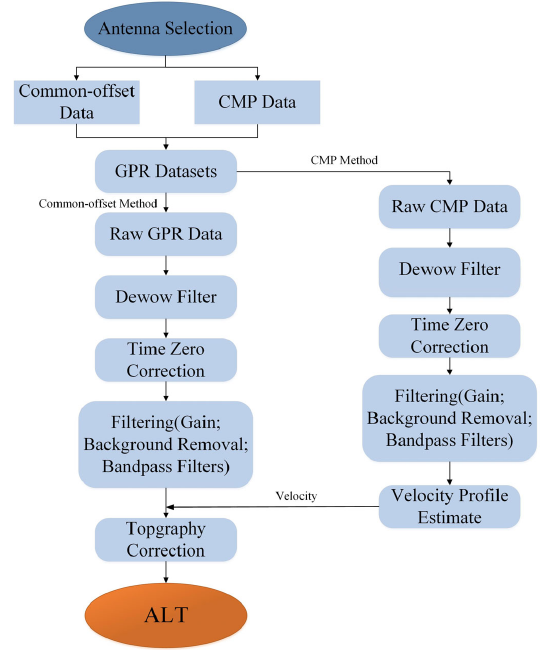
Figure 3. Flow chart of ground ‐ penetrating radar (GPR) data processing performed to derive the active layer thickness (ALT). CMP: common midpoint. active layer thickness (ALT). CMP: common